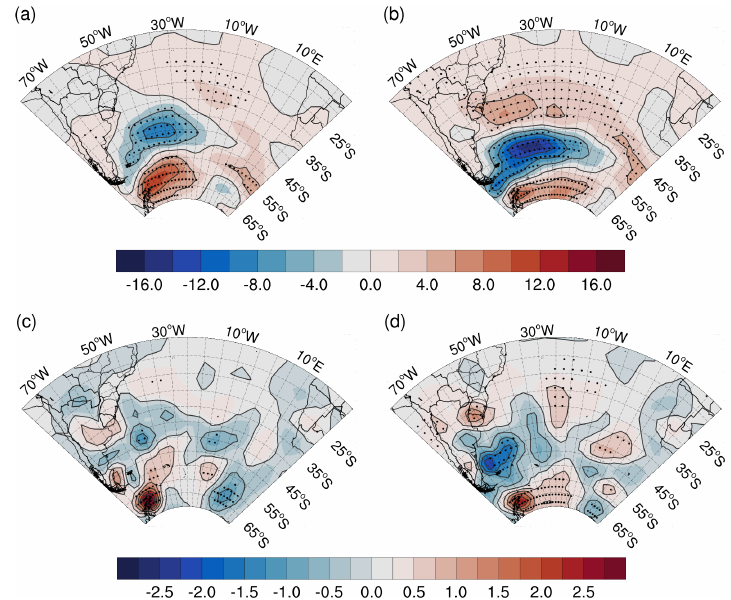
Figure B2. Cyclone (a, b) track and (c, d) genesis density differences between phases A and B of (a, c) EOF1 and (b, d) EOF2 of swh. Differences are calculated using phases A minus B and are also contoured by 5 density unit intervals for the track and 0.5 for the genesis. The black dots indicate where the difference is significant within a 95% confidence level. Density unit is the system per year per area, where area is in 10 6 km 2 ( ∼ 5 ◦ spherical cap).